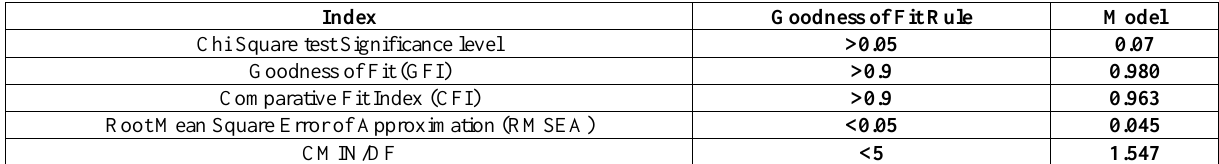
Figure 9. The Interpretive Structural Equation Model After Modification Table 5. Fitting Index of Confirmatory Factor Analysis of